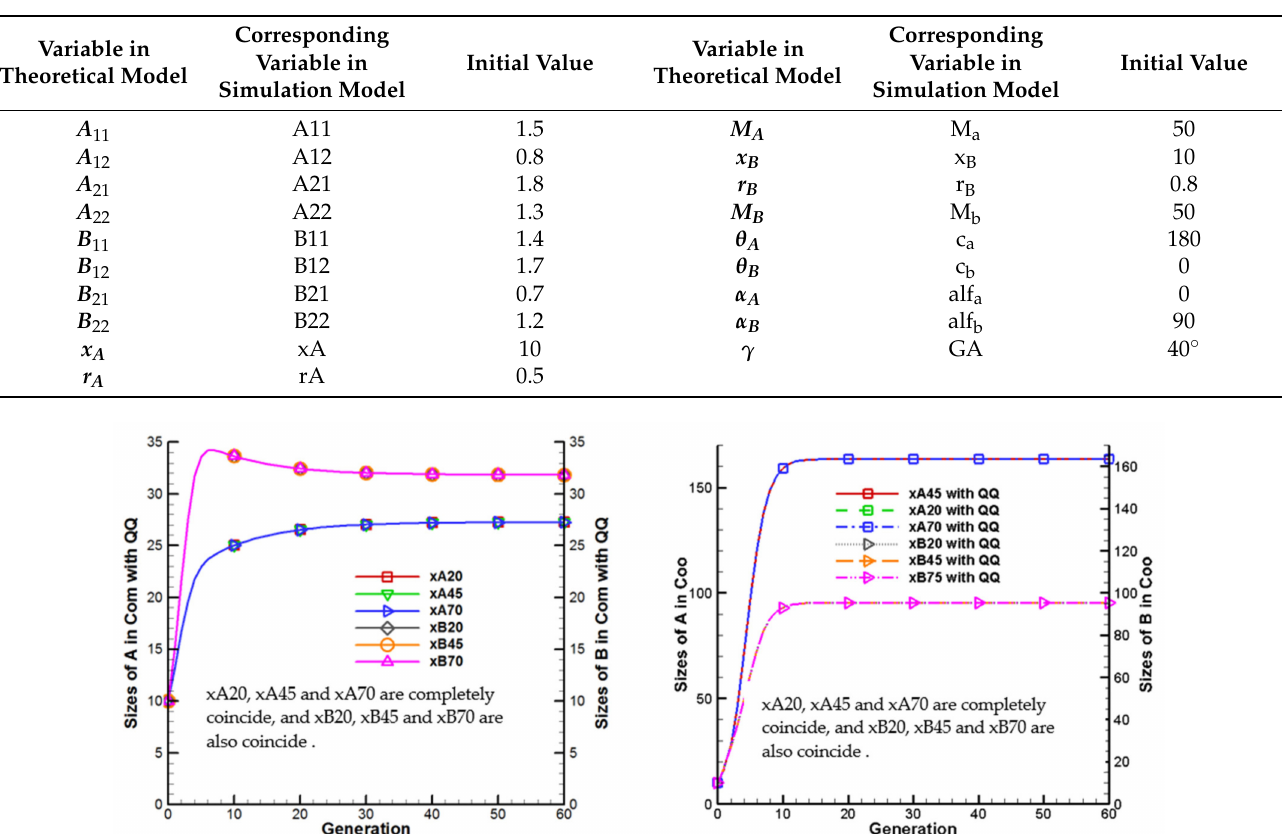
Figure 2. Schematic diagram of system dynamics simulation of the improved L–V model. Table 7. Variables and initial values for the theoretical and simulation model.